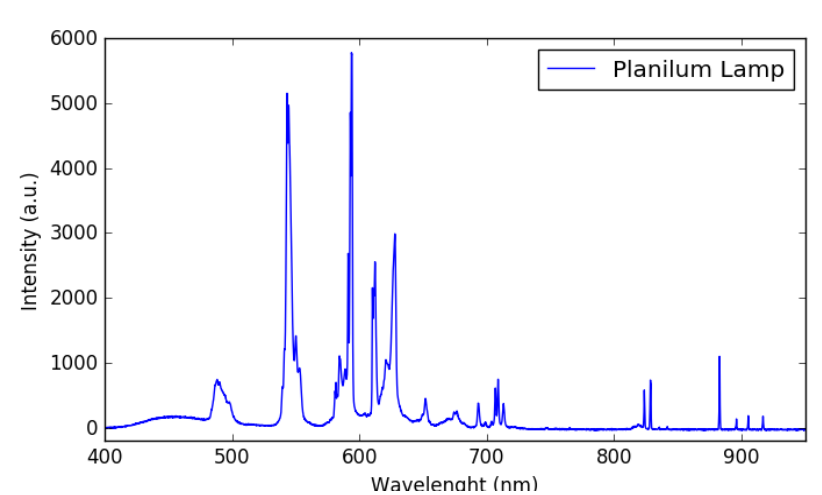
Figure 3. Typical optical spectrum of Planilum© lamp with standard conditions and commercial ballast (2000 V-20 kHz).